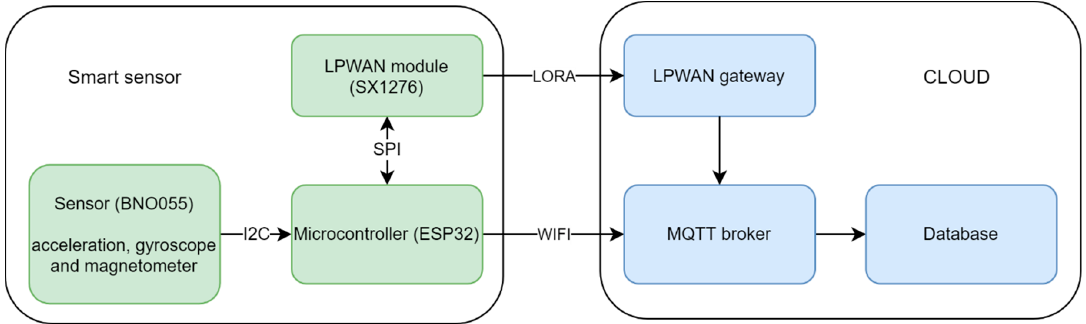
Figure 4. Smart sensor and cloud block diagram.